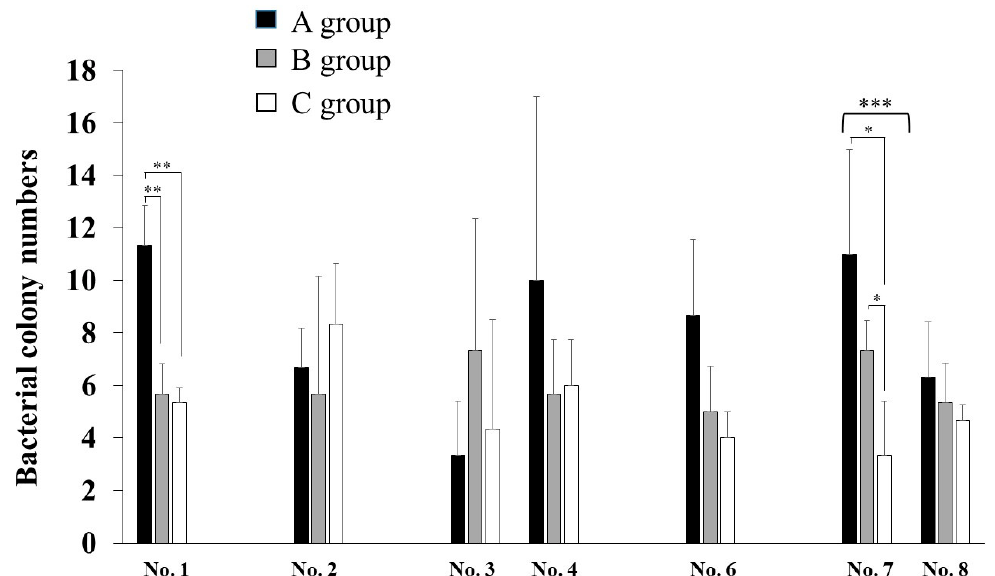
Figure 4. Bacterial numbers in droplets and aerosols that fall around the dental chair. Areas positively detected in the A group (None) were selected, and the effects of the B group (oral suction) and the C group (extraoral and oral suctions) on the bacterial numbers grown on BUI and R2A agar plates are presented. Locations in No. 1–4 and No. 6–8 were indicated in Figure 1. The data indicate the mean ± standard deviation (SD) of three independent experiments. The asterisks indicate a significant difference between two groups (*: p < 0.05, A vs. C, and B vs. C) and (**: p < 0.05, A vs. B, and A vs. C), and among the three groups (***: p < 0.05, A–C).